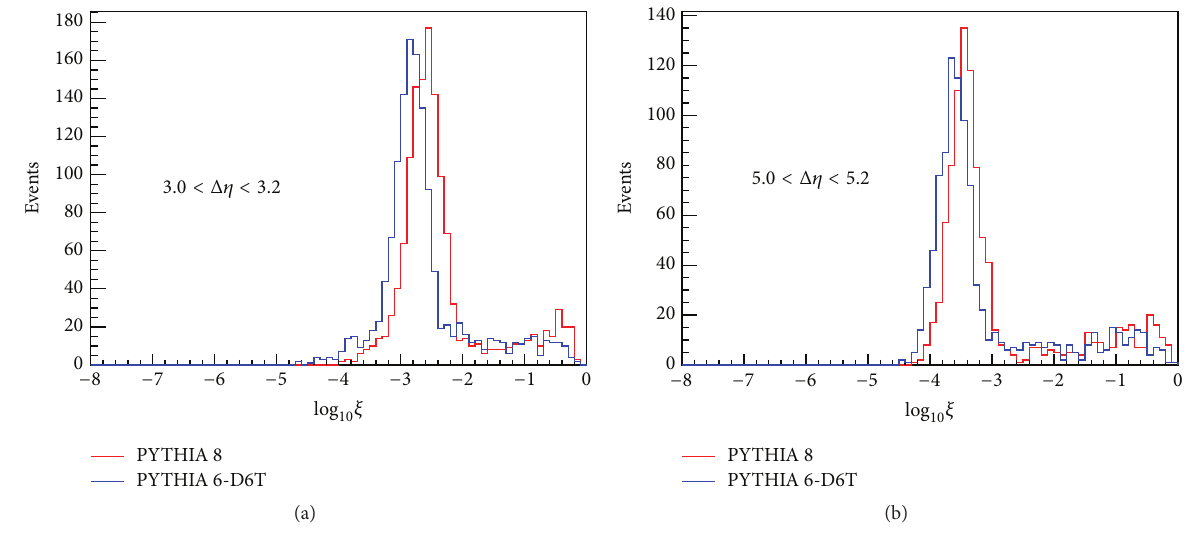
Figure 14: The range of 𝜉 values for SDD events with a gap size (a) 3.0 < Δ𝜂 < 3.2 and (b) 5.0 < Δ𝜂 < 5.2 . Events are simulated by PYTHIA 8 and PYTHIA 6-D6T, and only edge gaps are considered with a cut of 𝑝 T > 200 MeV for the final state particles in |𝜂| < 5.2